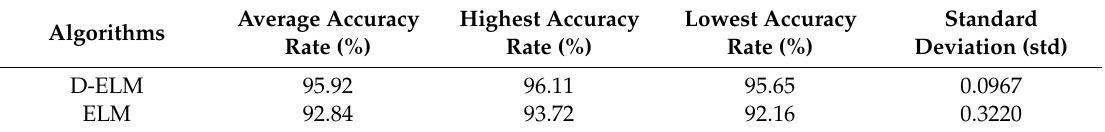
Table 3. D-ELM versus ELM stability.